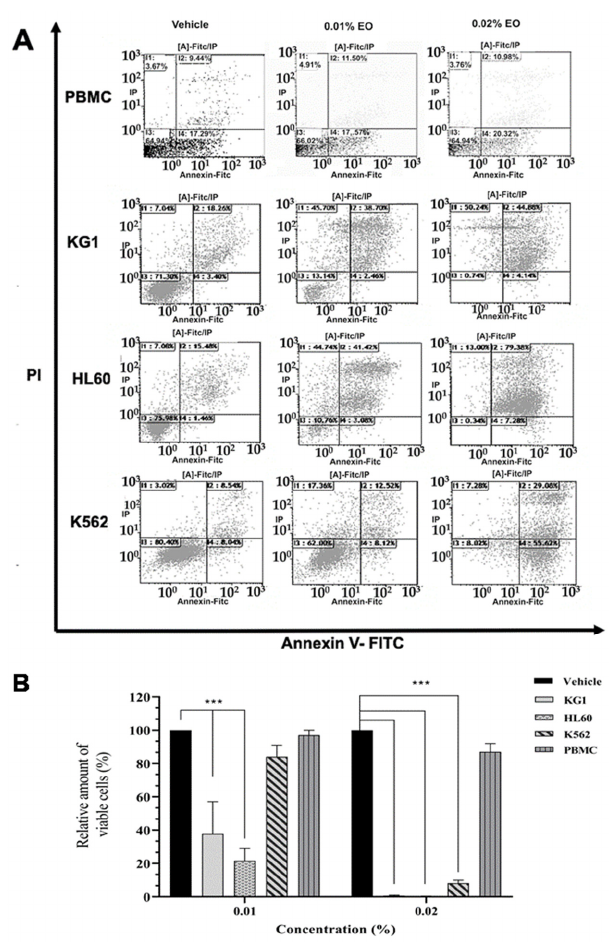
Figure 2. ( A , B ) Cell cytotoxicity of Ptychotis verticillata Essential oil (PV EO) on myeloïd leukemic cell lines and peripheral blood mononuclear cells (PBMCs) from healthy donors. ( A ): Flow cytometric analysis of cell death with Annexin V-FITC/PI double staining after 24 h treatment of KG1, HL60, and K562 cell lines with increasing concentrations of essential oil. Data were analyzed by Kaluza software 2.1. ( B ): The quantification of myeloïd leukemic cell lines viability compared to PBMCs from a healthy donor after their treatment with the same concentrations of PV EO (0.01% and 0.02%). Data represent the mean ± SEM of three independent experiments relative to vehicle. The levels of statistical significance were p < 0.001